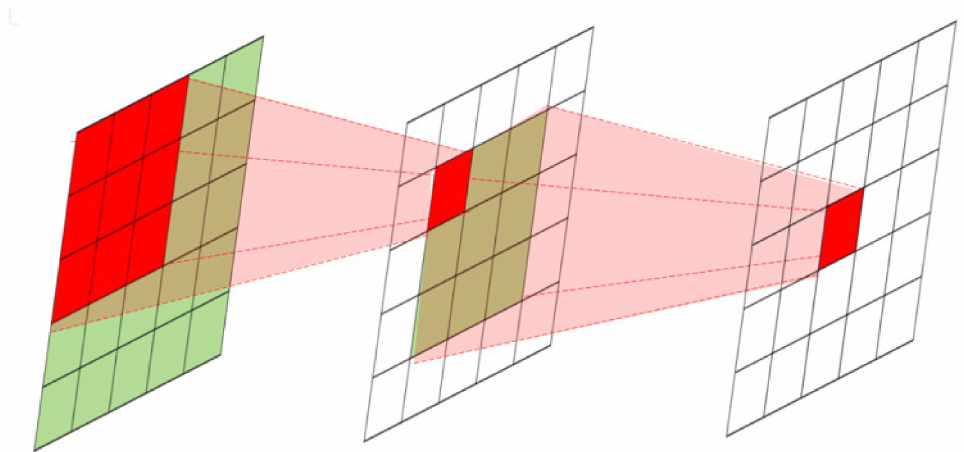
Figure 8. Schematic diagram of two cascaded 3 × 3 convolutions, whose receptive field is equivalent to a single 5 × 5 convolution.